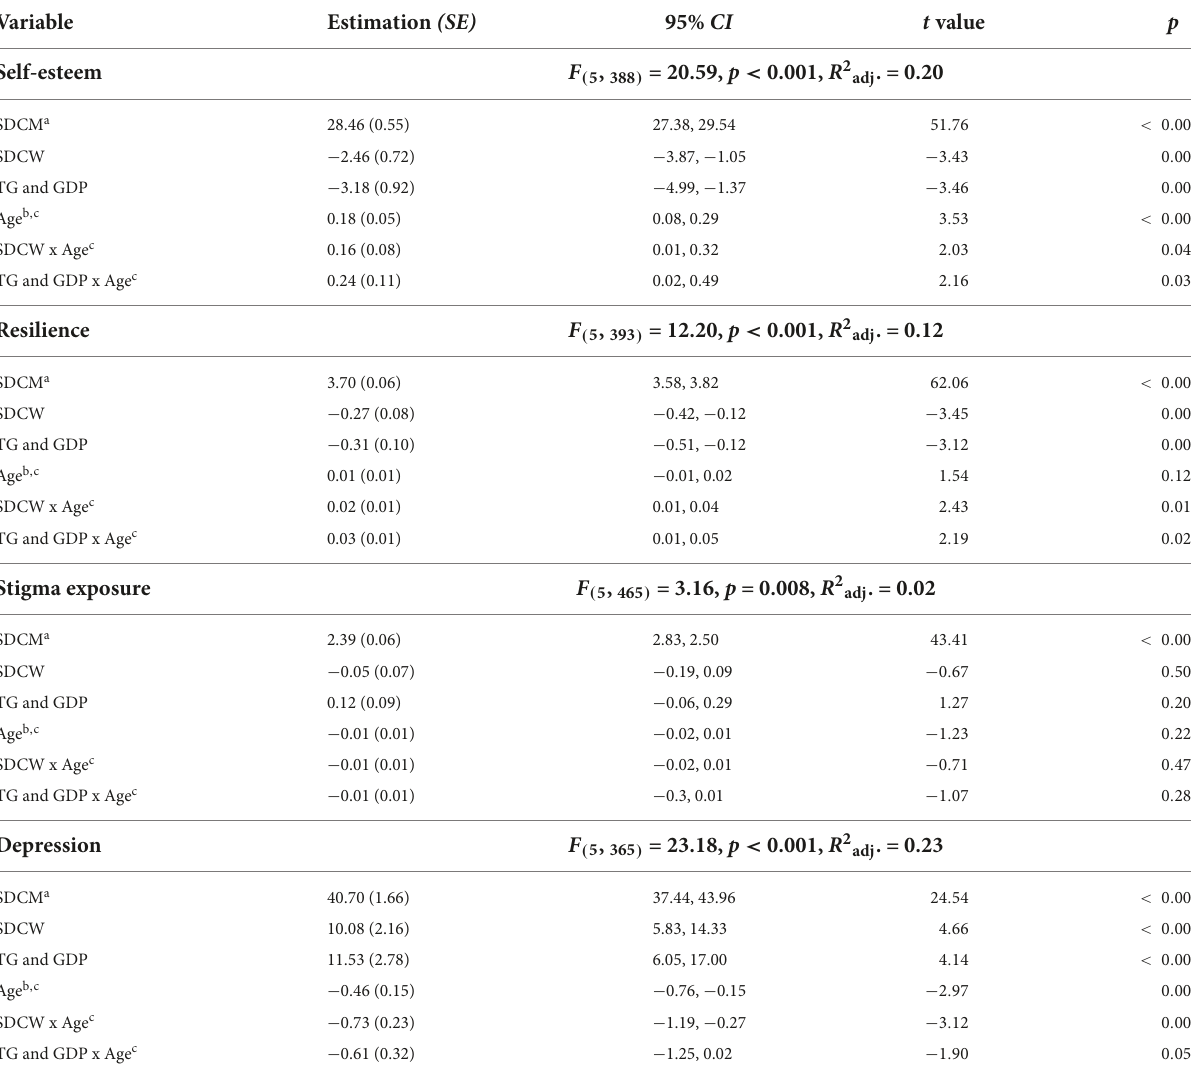
TABLE 4 Linear models for self-esteem (RSES), resilience (SPP-25), stigma (DHEQ), and depression (CESD-R). Variable Estimation